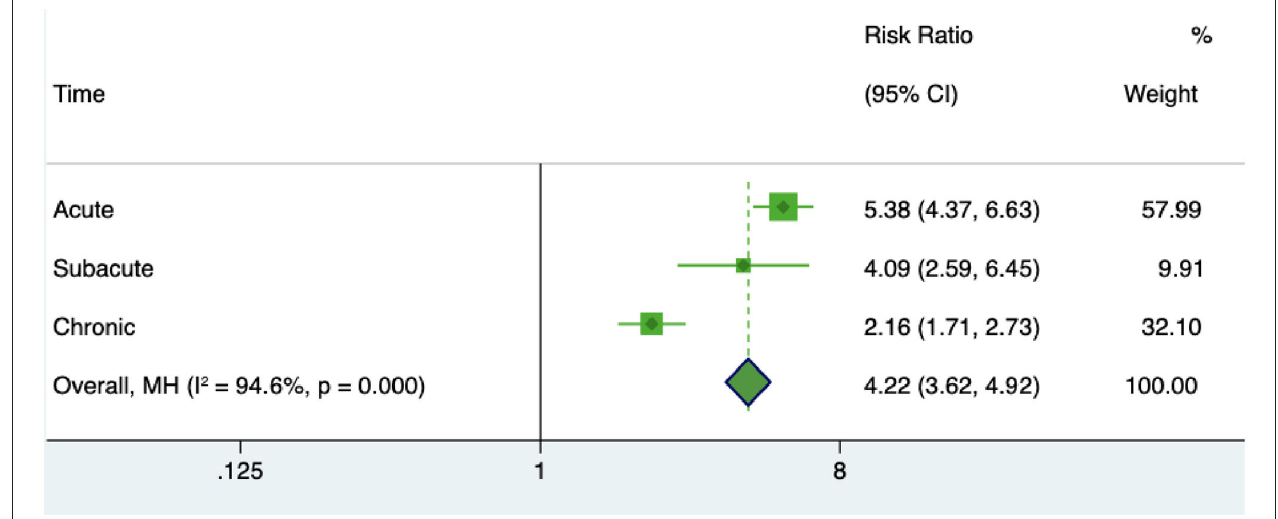
FIGURE 6 | Forrest plot of risk ratio of miRNAs in different stages of